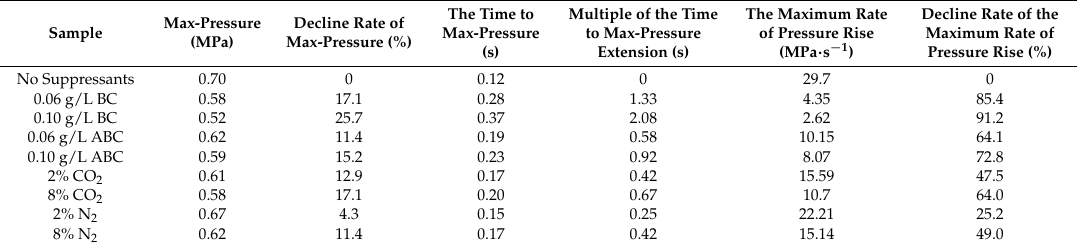
Table 1. The explosion characteristic parameters of methane under a single-phase inhibitor.